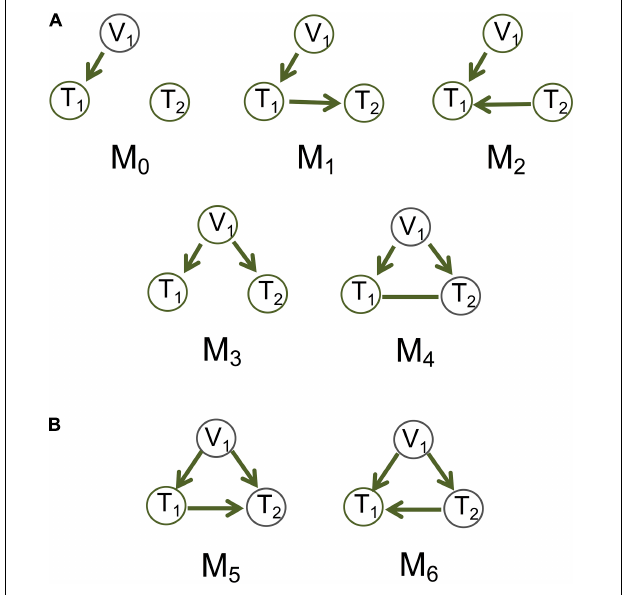
FIGURE 1 | Basic causal graphs under the principle of Mendelian randomization. (A) The five basic (inferred) causal graphs. Each includes a genotype node (also an instrumental variable), V 1 , and two phenotype nodes, T 1 and T 2 . (B) Two DAGs M 5 and M 6 are Markov equivalent, and can both be represented by M 4